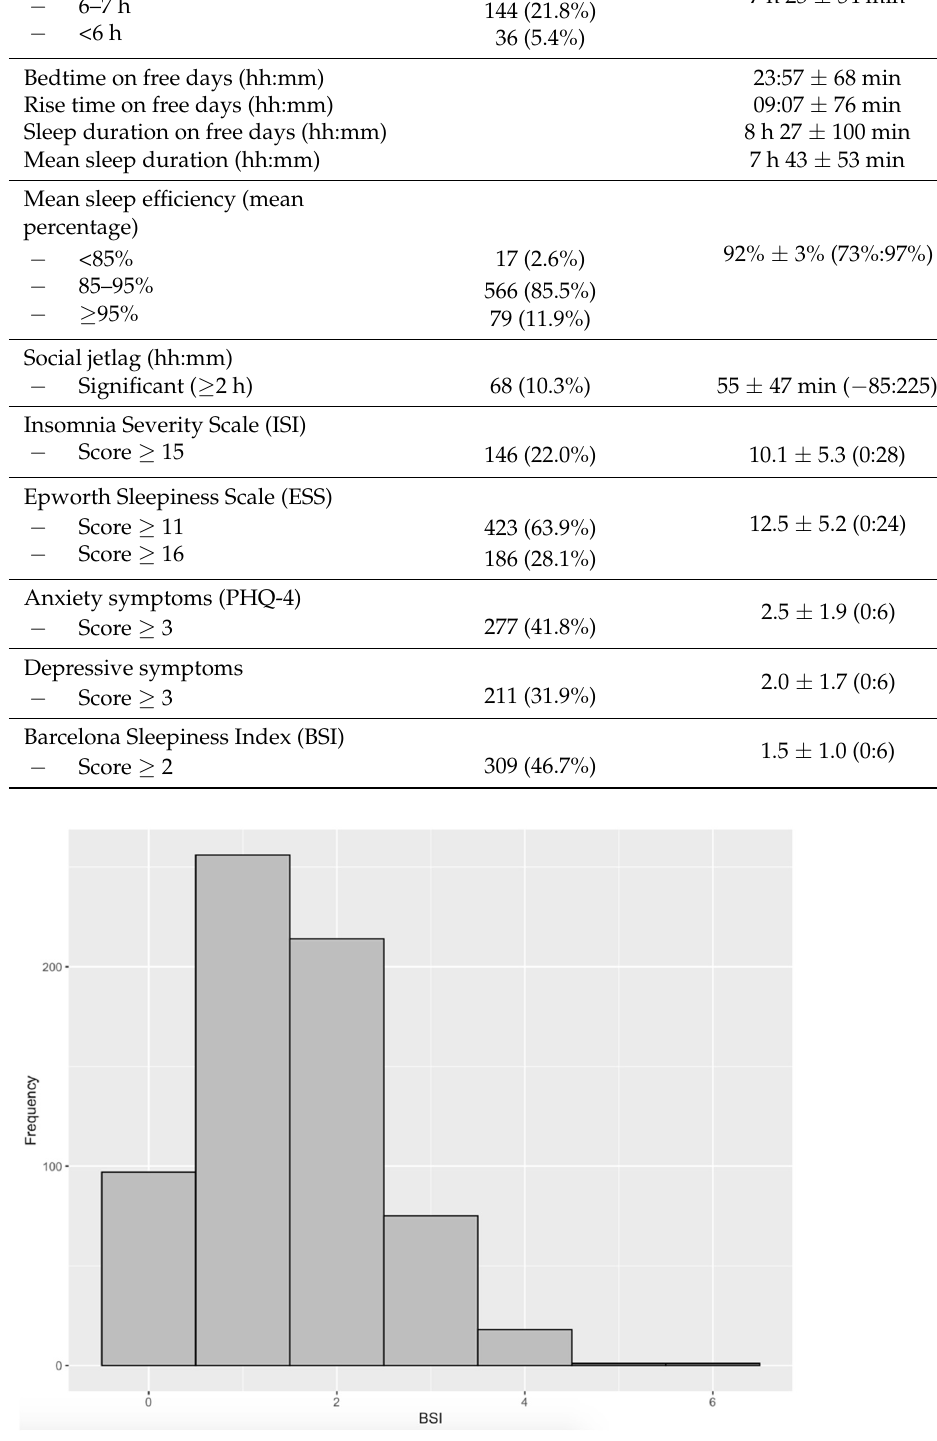
Figure 1. Frequency histogram of the BSI score ( n = 662).